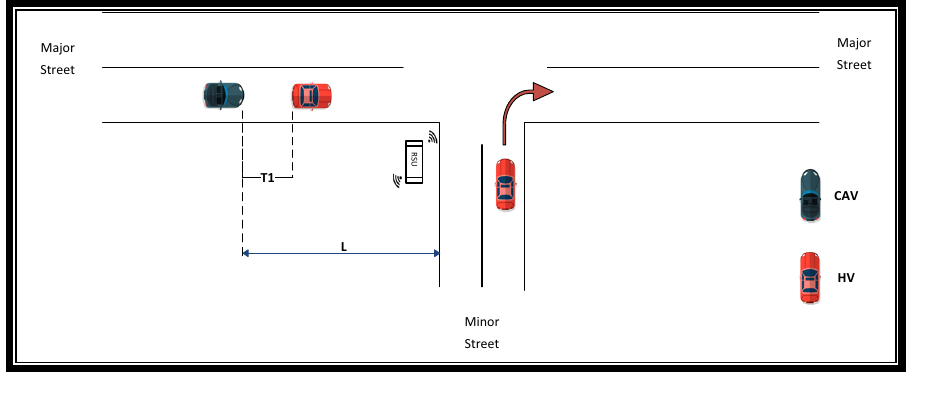
Figure 4: Front gap between CAV and the leading vehicle, T 1 .